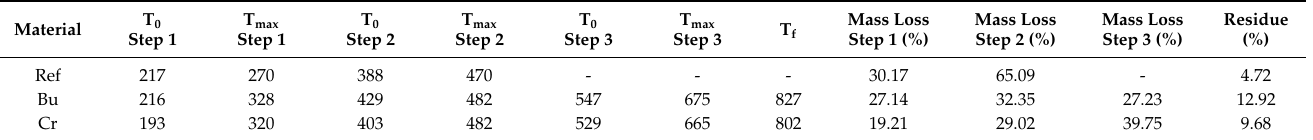
Table 9. TGA results for compounds used in co-extrusion. Abbreviations: T 0 : first onset; T max : maximum degradation temperature (maximum rate of degradation); T f : final degradation temperature. Values for T 0 , T max, and T f in ◦ C.